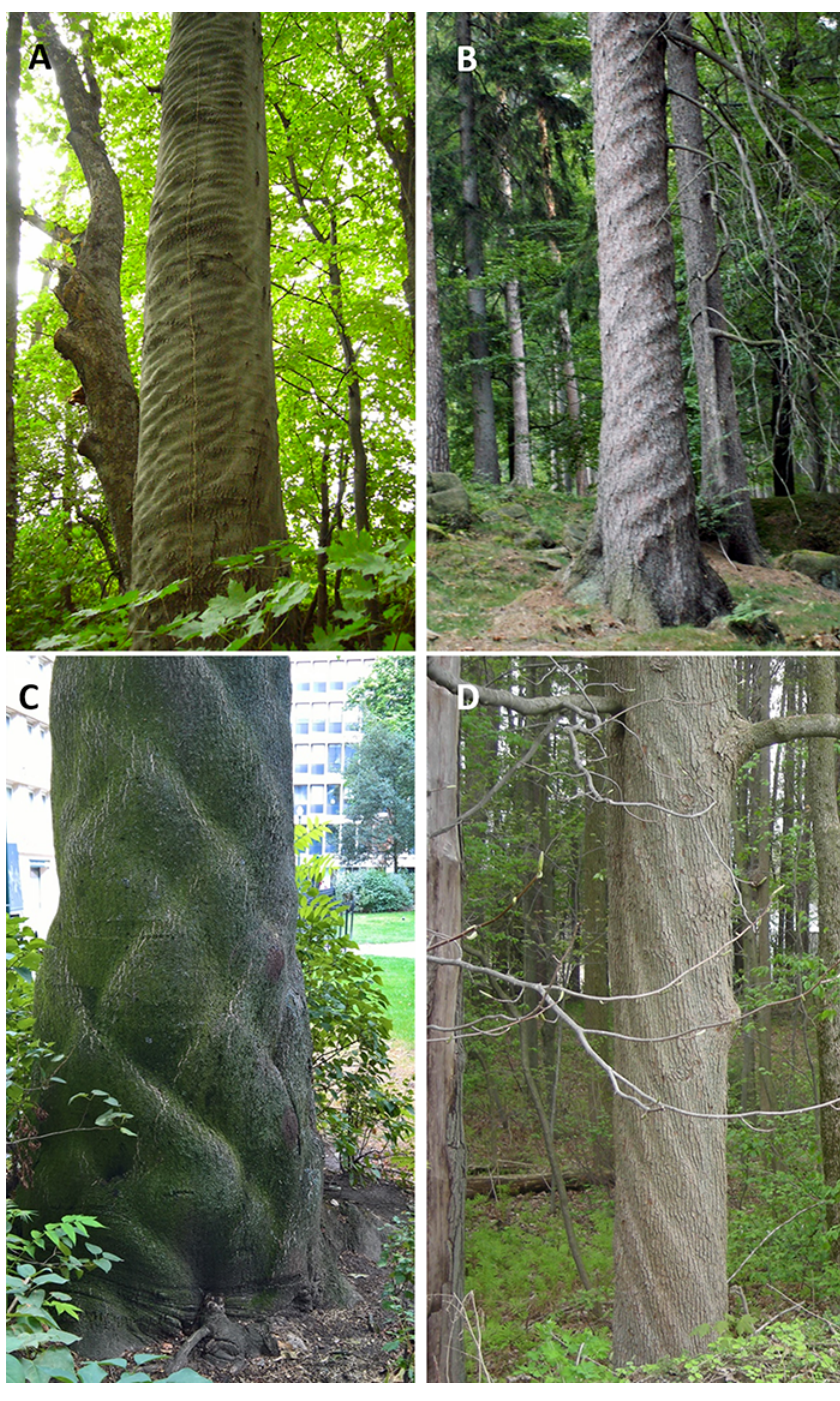
Figure 1 Four individual tree trunks, each with a distinct ripple pattern. ( A ) Fagus sylvatica , Jastrowiec, Poland; ( B ) Picea abies , Sudety Mts, Poland (photo: Piotr Kiciński); ( C ) Ailanthus altissima , Brussels, Belgium; ( D ) Magnolia acuminata , southern Ontario, Canada (photo: Anita Figlar); ripples are right-slanted in ( A,B ), and le-slanted in ( D ).